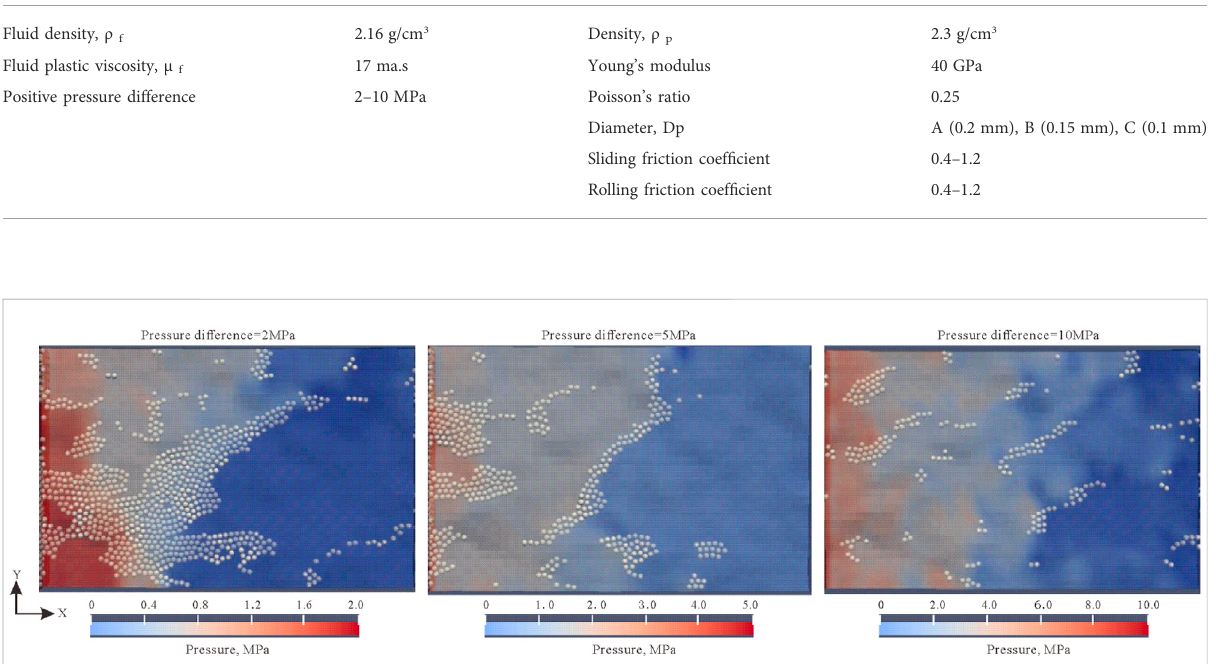
FIGURE 5 VariationoffractureplugginglawunderdifferentpositivepressuredifferencesinJRC15(attheparticleconcentrationof10%,frictioncoef fi cient of 0.9, particle size of 100% A).